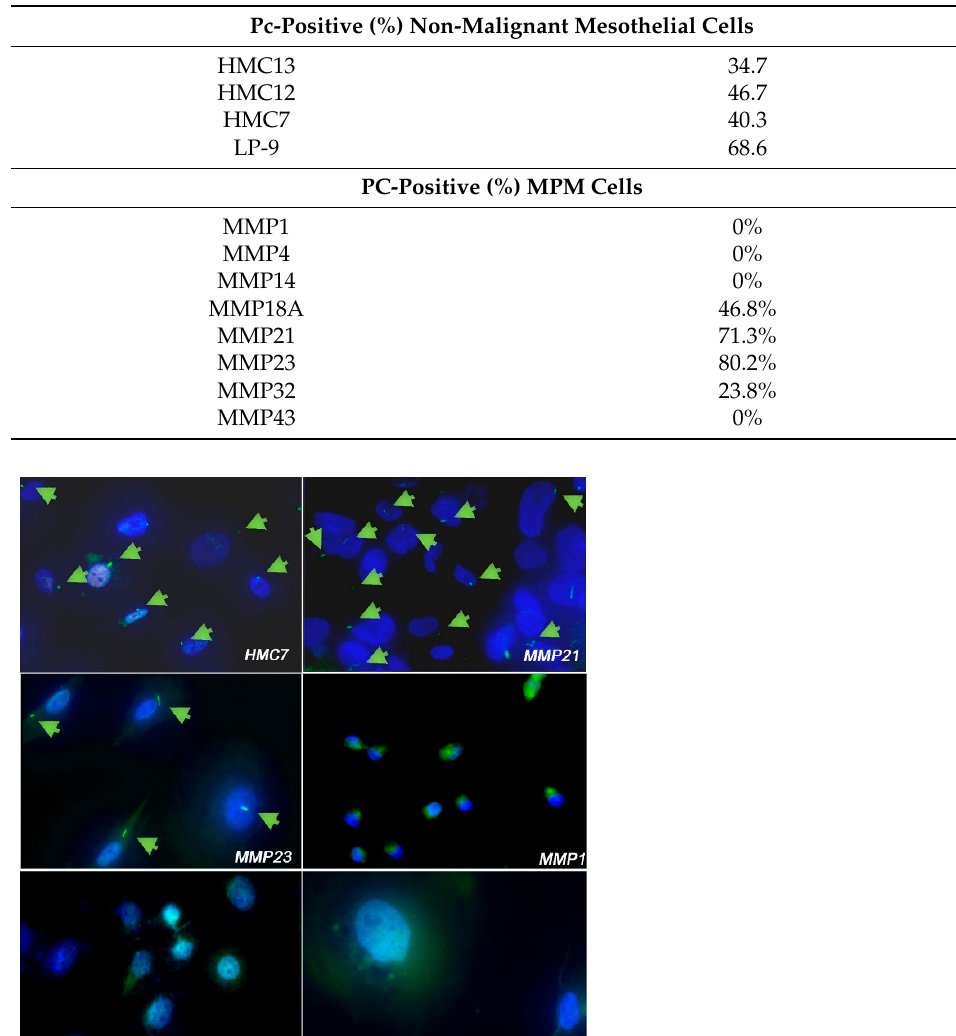
Figure 3. qRT-PCR analysis of GLI1 , PTCH1 and c-MYC. The expression of Hh-related genes is upregulated in MPM cells loosing PC (gray bars), compared to normal mesothelial cells HMC7. (* p < 0.05, ** p < 0.01, *** p < 0.001, **** p < 0.0001).